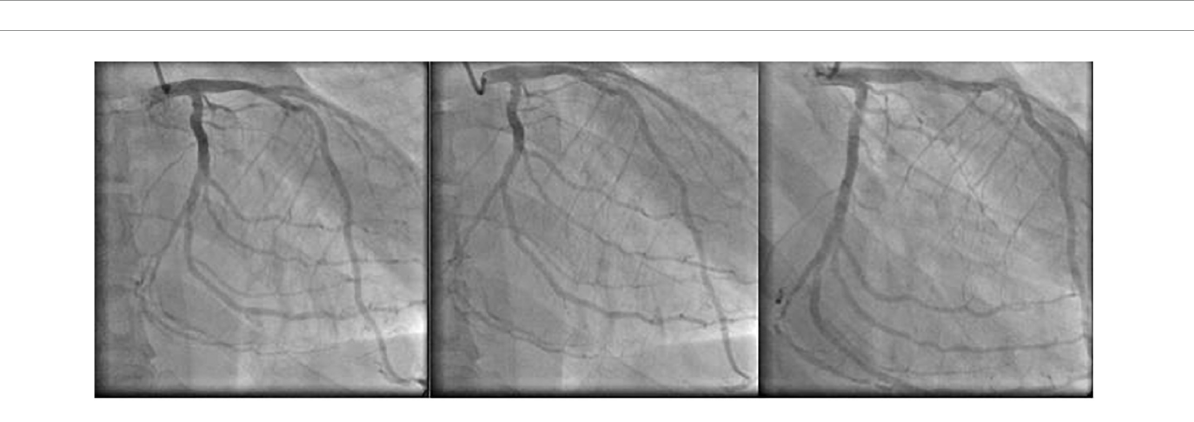
FIGURE2 Coronary angiography: sequence of different frames.